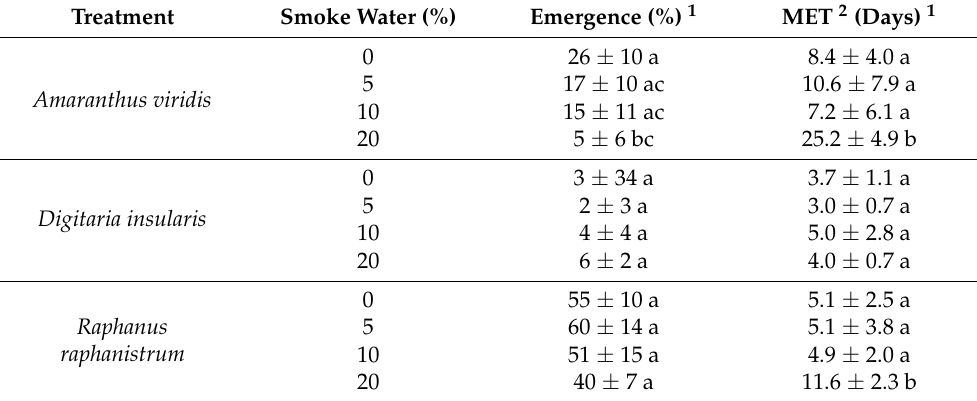
Table 2. Effect of smoke solutions on seed emergence of weeds in a greenhouse. Treatment